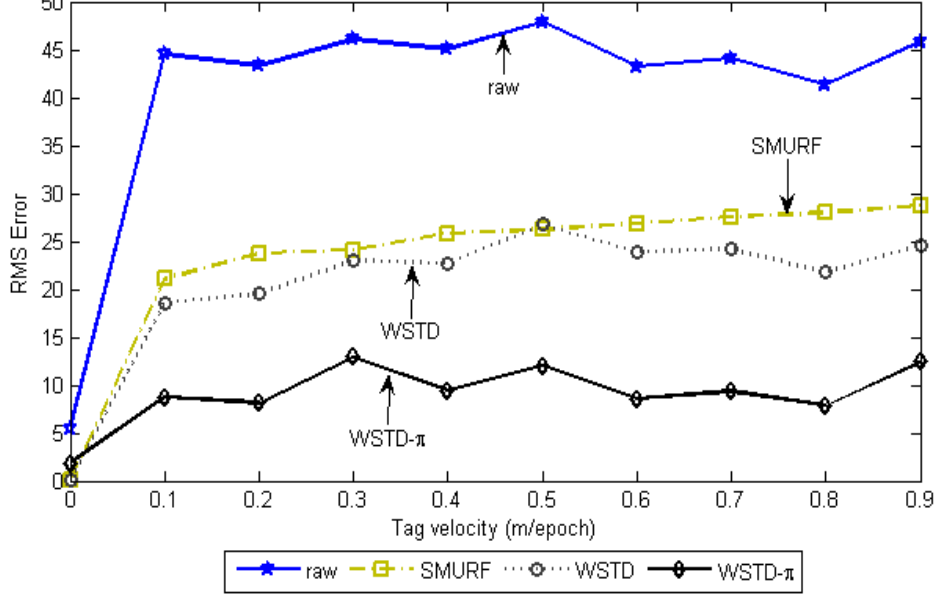
Figure 16. The RMS error of different cleaning schemes counting 100 tags as their velocities varies from 0 to 0.9 m/epoch in the noisy environment with the StrongPercentage parameter set to 25%.